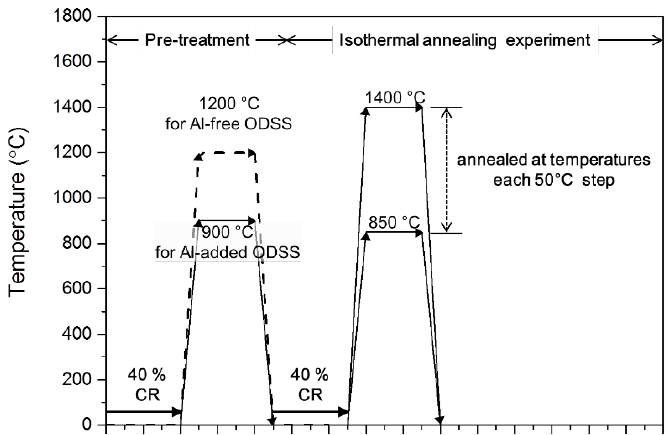
Figure 4. A series of cold rolling and recrystallization annealing was performed prior to the isothermal annealing experiment. The pre-treatment was such that for as-received materials being 40% cold rolled and annealed at just below the recrystallization temperature which is 900 ◦ C for Al-added and 1200 ◦ C for Al-free ODS steels. Then, the second cold rolling with 40% reduction ratio was performed and followed by the isothermal annealing for 1 h at temperatures between 850 ◦ C and 1400 ◦ C with steps of 50 ◦ C. The isothermal annealing with and without pre-treatment are called dual and single processing. Here, the rolling direction of first and second rolling was parallel to the extruded direction.